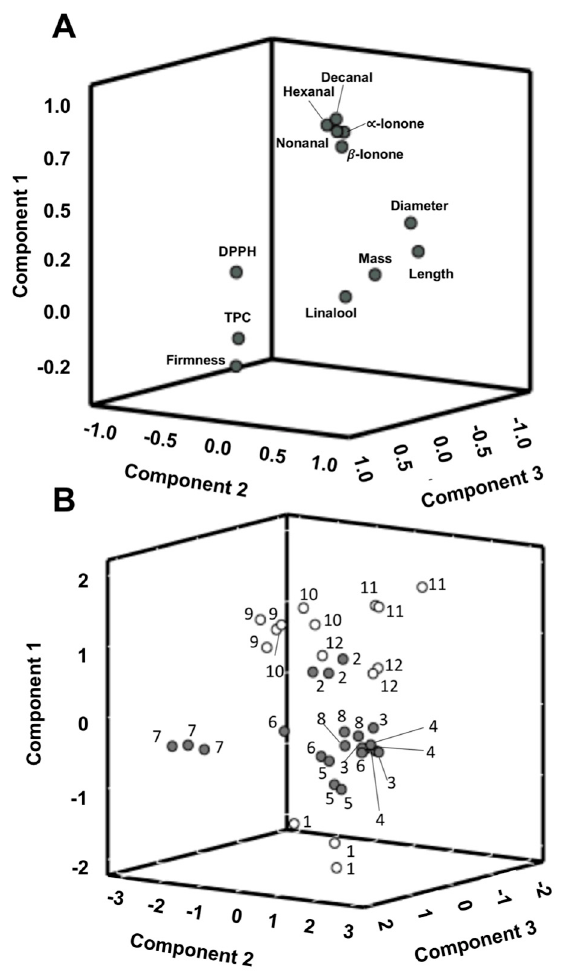
Figure 5. ( A ) 3-D projection of parameters onto a Principal Component Analysis (PCA) plot constructed from the principal component analysis of the data; ( B ) PCA-score plot of samples grouped in Group 1 (•) and Group 2 (°) of the cluster analysis with 1: sample “Adelita” (S1), 2: “P04”